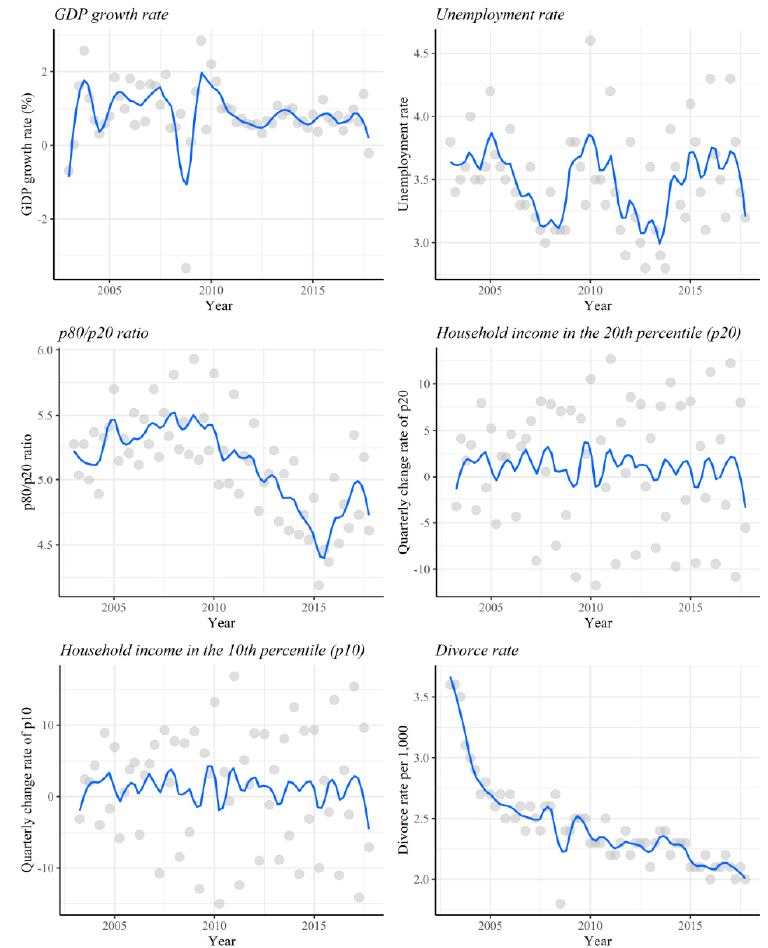
Figure 2. Time trend of socioeconomic variables from 2003 to 2017.